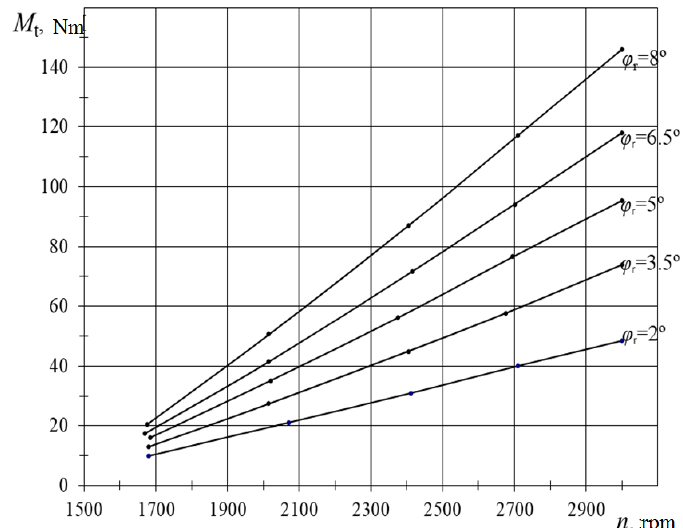
Figure 13. Speed characteristics of the SGEU-100 brake stand.